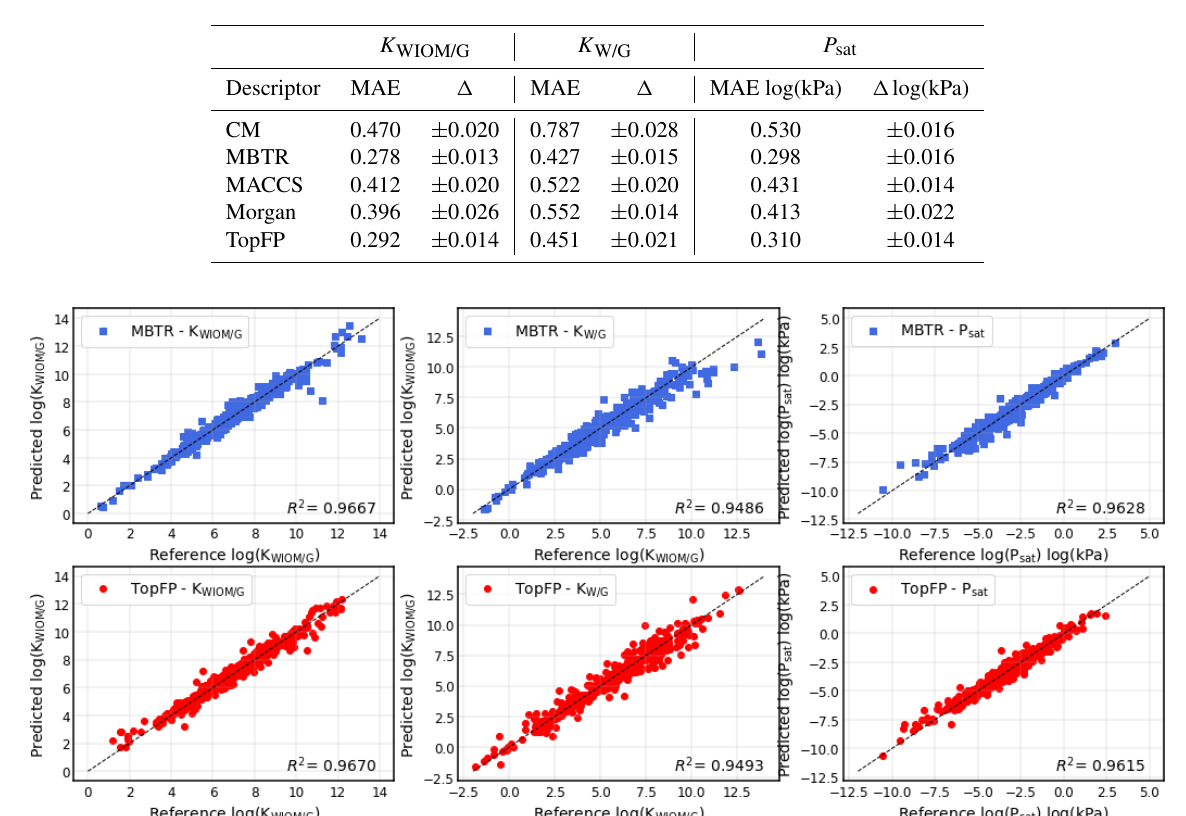
Table 2. The mean average errors (MAEs) and the standard deviations for all the descriptors and target properties (equilibrium partitioning coefficients K WIOM/G , K W/G , and saturation vapour pressure P sat ) with the largest possible training size of 3000.